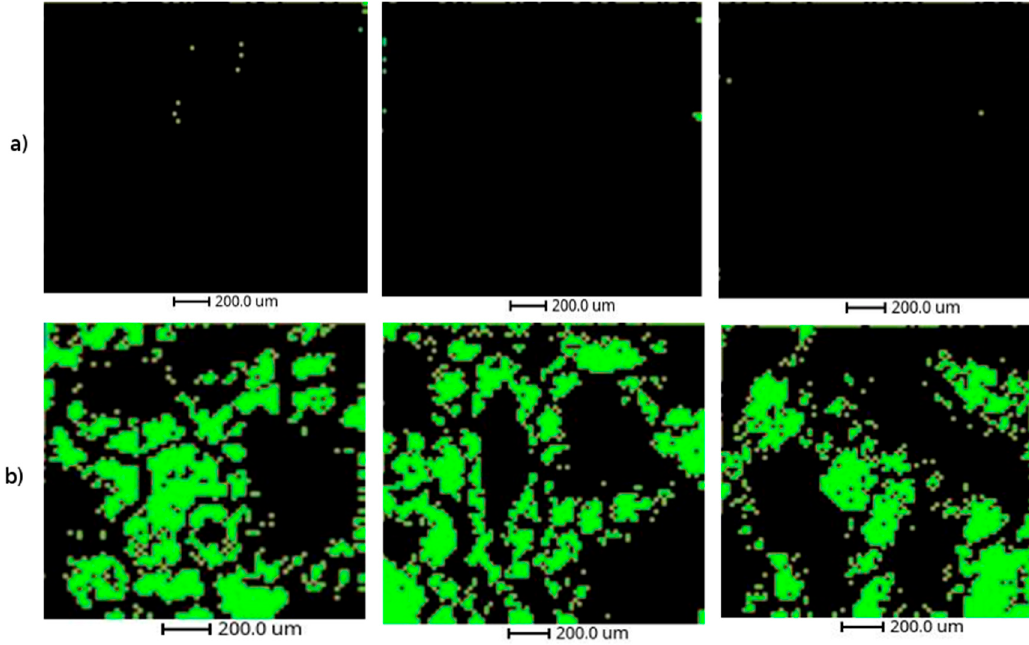
Figure 6. Representation of cluster 2 of the six liver samples: ( a ) the three analytical replicates of a control mouse and ( b ) the three replicates of a thirdhand smoke (THS)-exposed mouse.